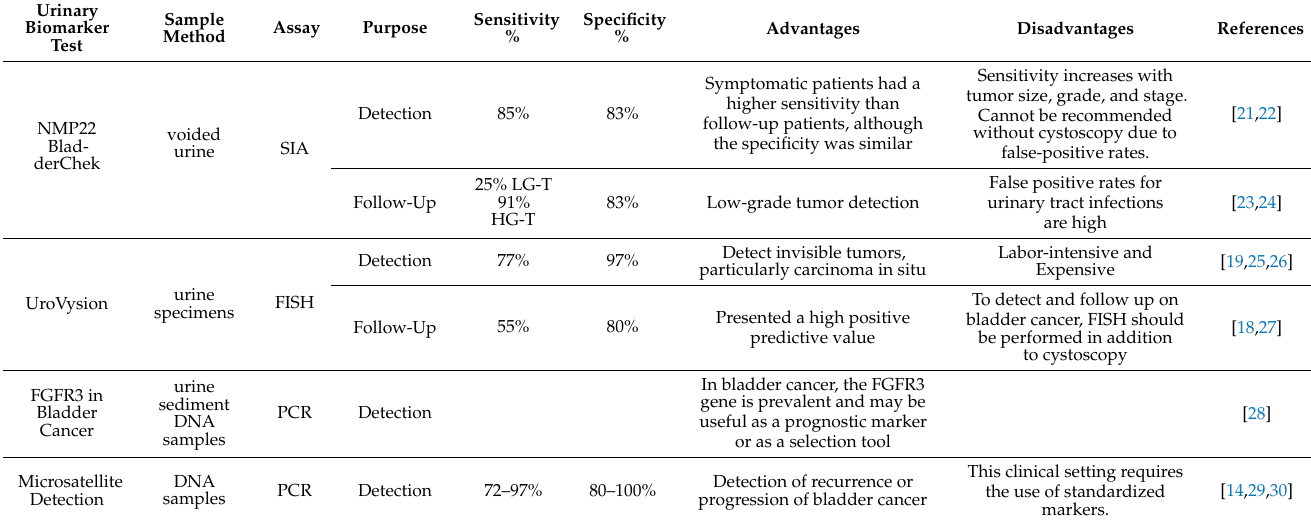
Table 1. The results of a literature search using Scopus complete and PubMed from 2015 to